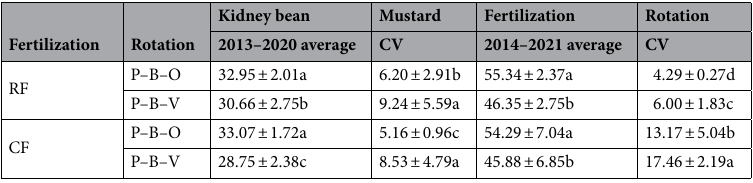
Table 2. Changes in kidney bean and mustard yield in different years by rotation system for two fertilization modes (kg/plot). Numbers followed by the different letter in a column show significant difference at P <